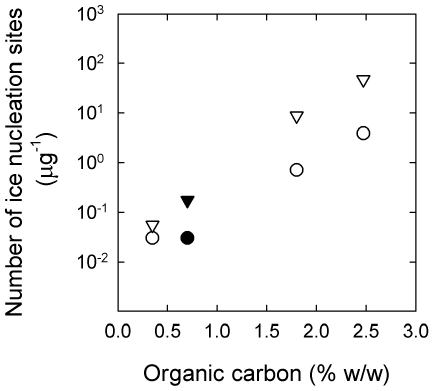
Fig. 2. Relationship between the number of ice nucleation sites and soil organic carbon (w/w) in soil dusts ( < 15µm) from Western Mongolia. Closed symbols are for data from soil A in Fig. 1. Open symbols are for soil dusts collected between 9 and 313 km from soil A. Circles and triangles show the number of ice nucleation sites active at − 8 ◦ C and − 12 ◦ C,